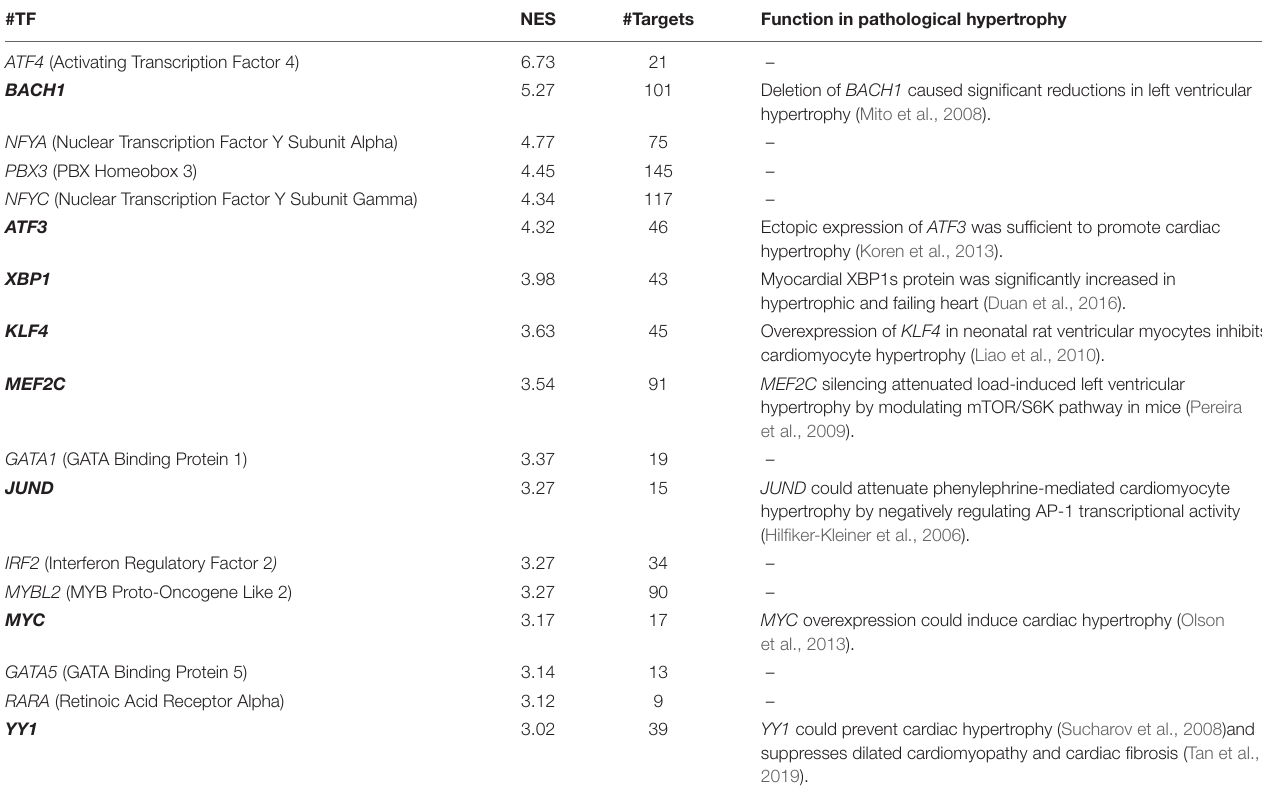
TABLE 3 | TFs potentially regulating the expression of 316